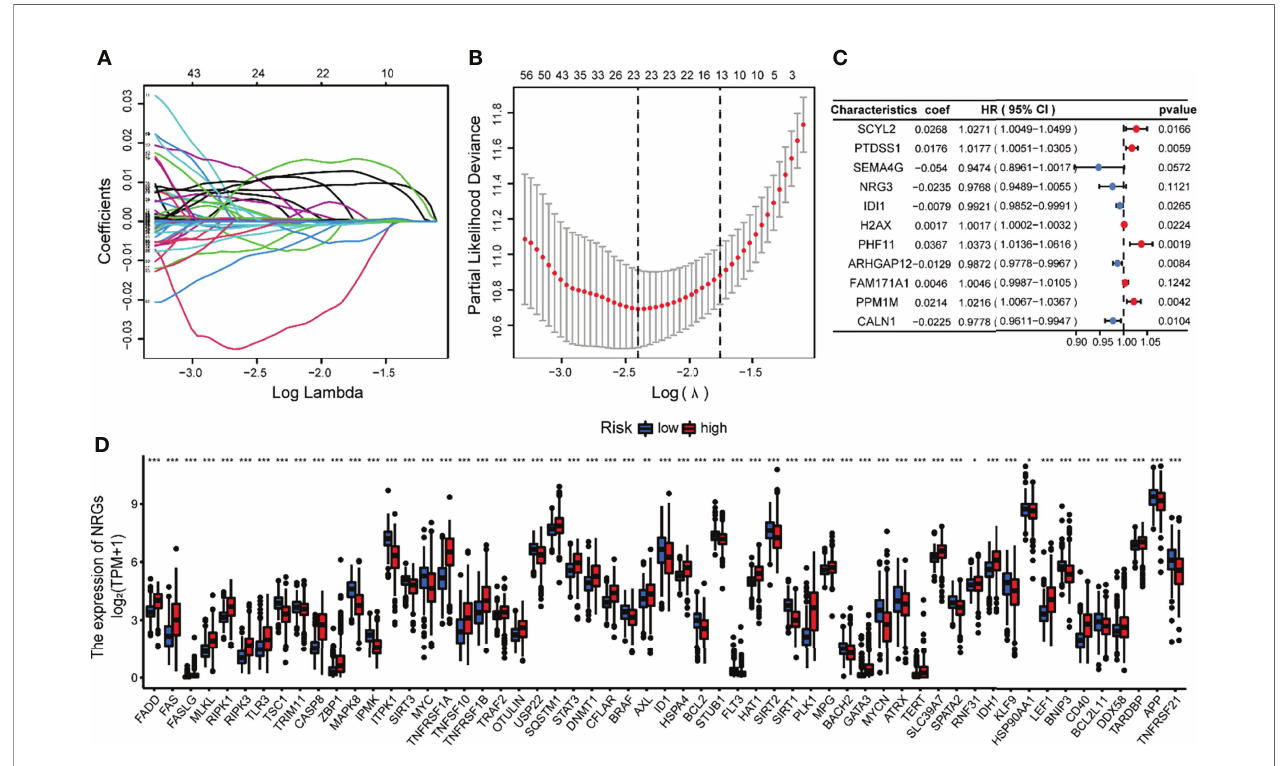
FIGURE 6 | Identi fi cation of representative candidate prognostic genes and differential expression of NRGs between the high and low-risk groups. (A) The LASSO regression analysis of the candidate prognostic genes. (B) The partial likelihood of deviance of the prognostic genes. (C) Forest plot of the multivariate Cox regression analysis for candidate genes. (D) The differential expression of NRGs between the high and low-risk groups. ***P<0.001, **P<0.01,